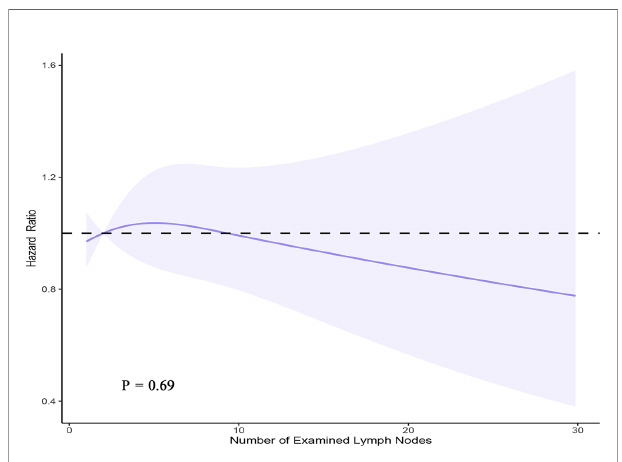
FIGURE 4 | Smoothed RCS plot of the adjusted hazard ratio vs. the number of LNs examined using the SEER registry data. The estimates were adjusted for patient age, sex, race, extent of surgery, number of metastatic LNs, extrathyroidal extension, and RAI administration. Three knots were placed at one, two, and nine nodes (corresponding to the 10th, 50th, and 90th percentiles,